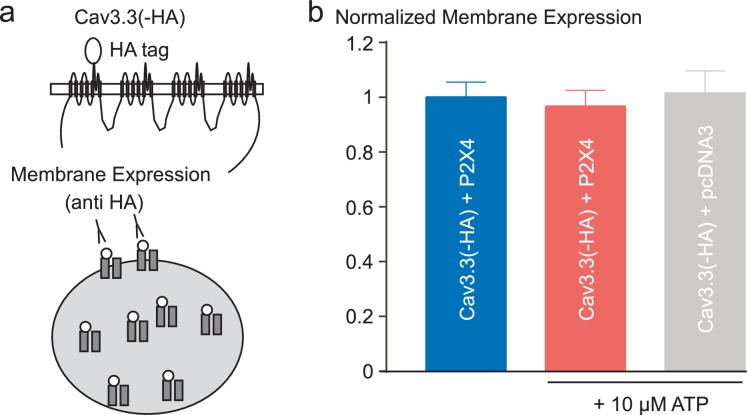
Effect of P2X4 activation on membrane density of Cav3.3 channels.(a) Schematic representation of a Cav3.3 channel construct containing an extracellular HA tag (located in the IS5-pore loop) used to measure its membrane expression in tsA-201 cells. The cells were co-transfected with the Cav3.3 channel and either the P2X4 receptor or the pcDNA3 plasmid. (b) Quantification by ELISA/luminometry of the membrane expression levels of HA-tagged Cav3.3 channels after treatment with 10 µM ATP. The histogram represents relative light unit (RLU) normalized toward the values obtained in the control condition (P2X4 without ATP treatment).